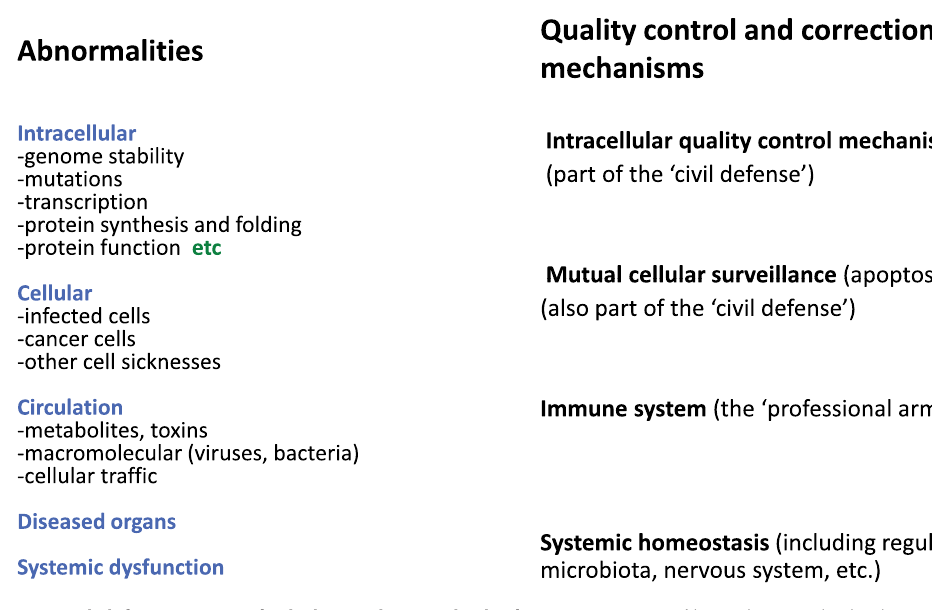
Figure 1. The natural defense system includes and exceeds the immune system. Aberrations and mistakes occur at all levels of the organism, and are listed on the left side. The major categories of quality control mechanisms are shown on the right. The immune system, (which makes up most of the ‘professional army’), covers one part. Intracellular quality controls, and mutual cellular surveillance (often by apoptosis) belong to ‘civil defenses’ which are individually exerted by all cells of the body (including those composing the professional army). Roads to diseases, and particularly to cancers rely on multiple aberrations that are not corrected by several of these quality